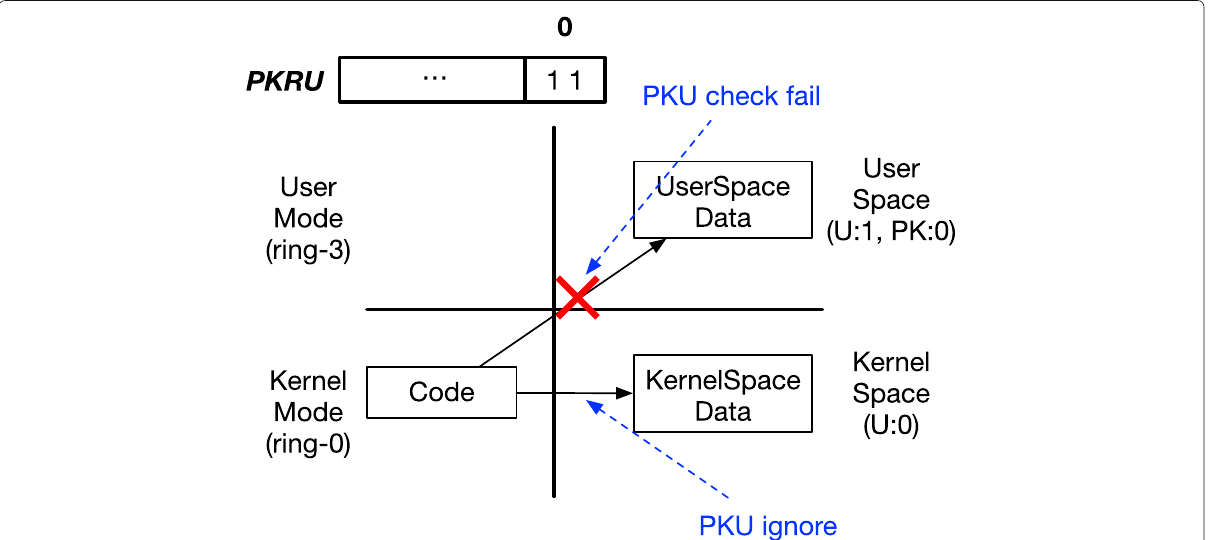
Fig. 3 MPK Protection. MPK will check the kernel memory accesses on user pages. “U” means user bit and “PK” means MPK protect key index in page table entry